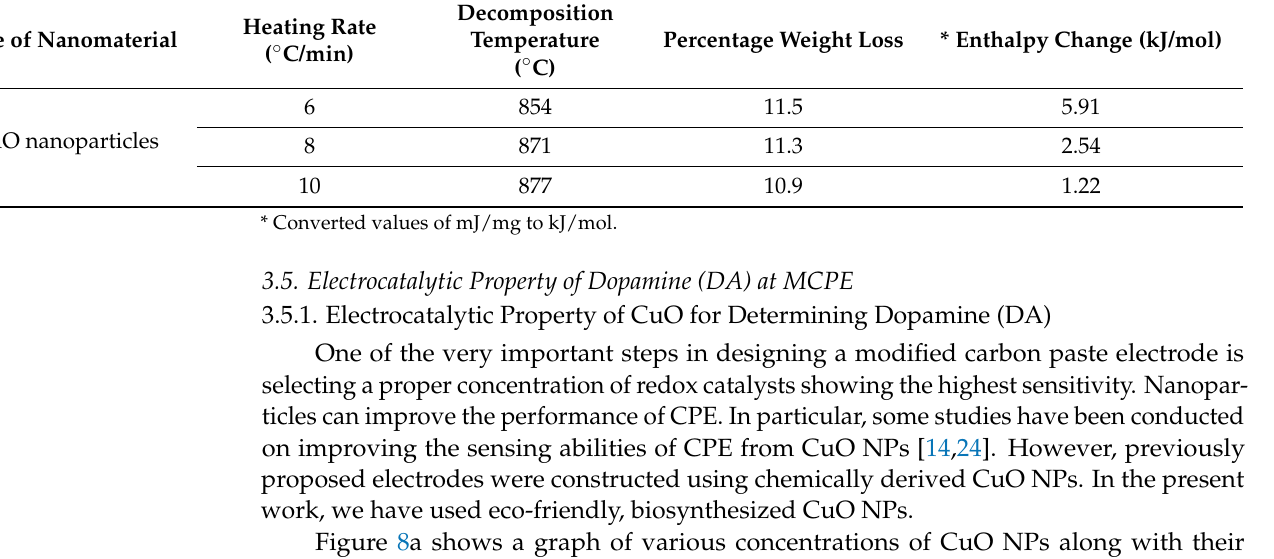
Table 2. The total weight loss, decomposition peak temperature, and enthalpy change of the CuO nanoparticles calculated using TG and DTA curves.